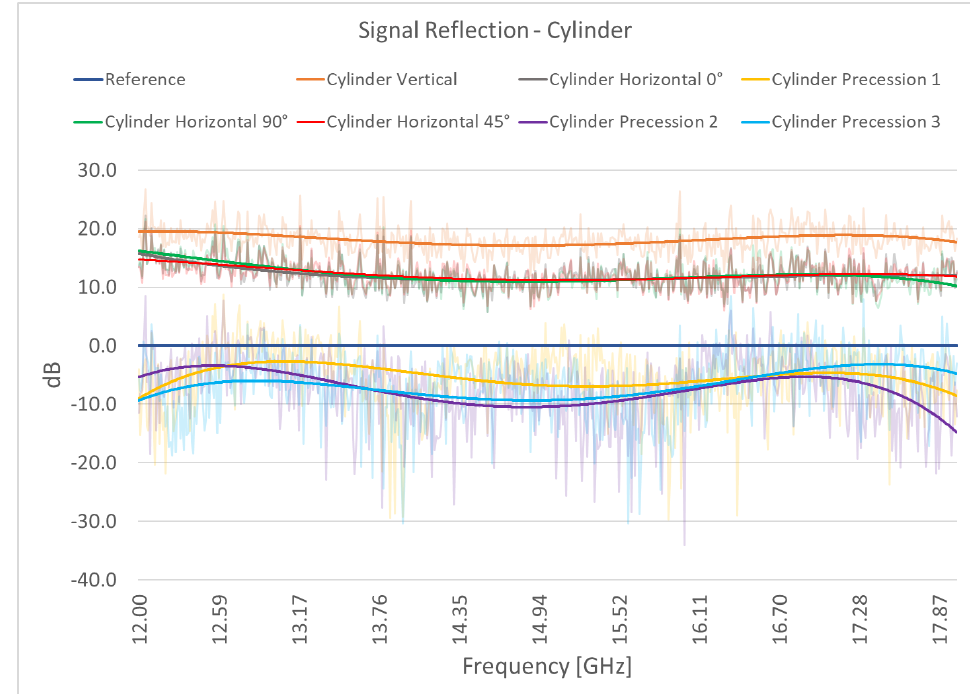
Figure 5. Cylinder signal reflection: TE polarization reflection vs. frequency.